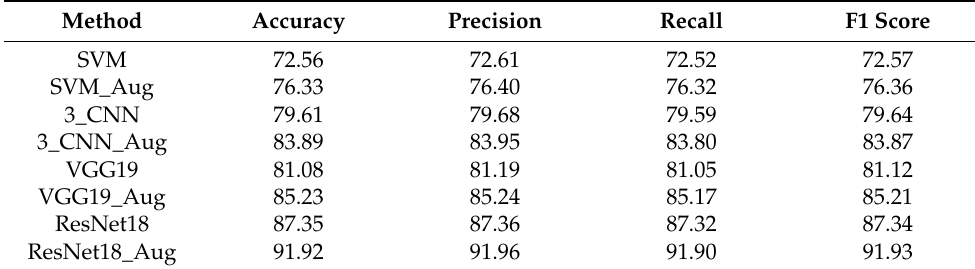
Table 4. Accuracy comparison (%) for the CQT by different methods.